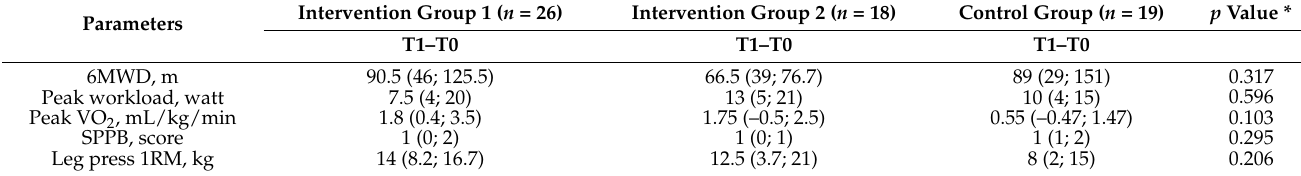
Values are medians (interquartile range). * p value by the Wilcoxon test. Bolded numerals indicate statistically significant differences. T0, baseline assessment; T1, assessment after CR; 6MWD, 6-minute walking distance; SPPB, short physical performance battery test; 1RM, one repetition maximum. Table 3. Changes in functional capacity and physical performance during rehabilitation by the groups.